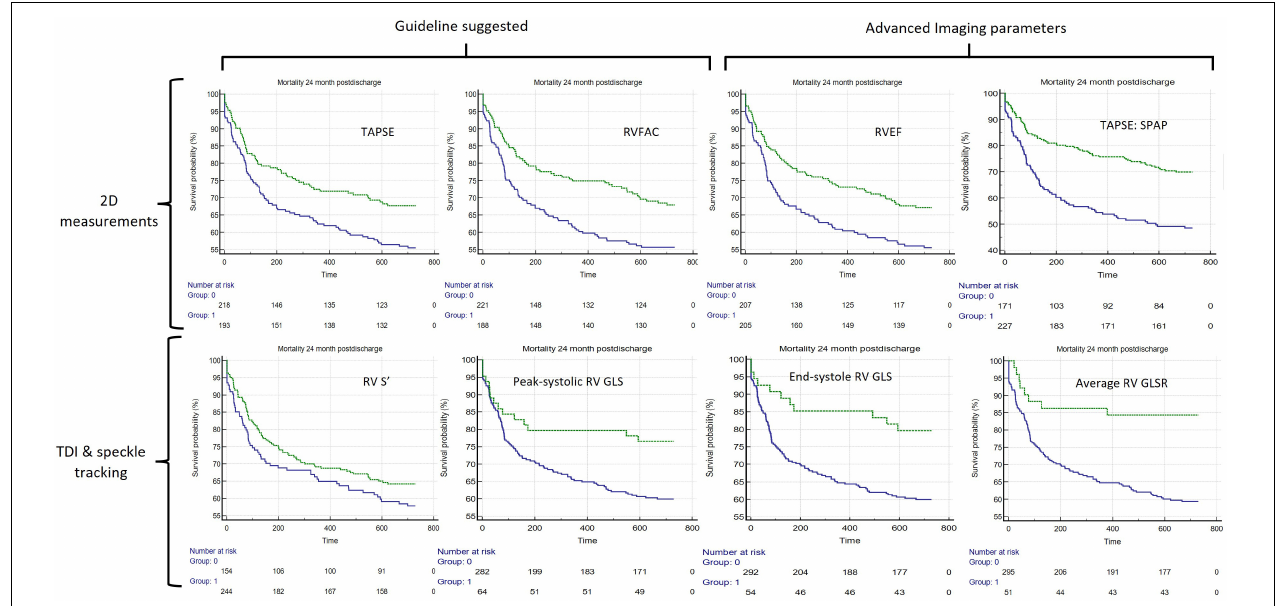
FIGURE 2 | Unadjusted Kaplan–Meier curves comparing 8 different assessments of RV systolic function, in all. The green lines represent the unimpaired systolic function and blue lines represent impaired systolic function. The echo parameter assessment of systolic function is displayed in the top-right corner of each (clockwise from top-left): TAPSE ≤ 1.6 cm, RV FAC ≥ 38.2%, 2D ellipsoid RVEF < 46.9%, TAPSE:SPAP < 0.0268 (cm/mmHg). RV S’ ≤ 0.09 m/s, Peak systolic RV GLS > − 18.6%, End-systole RV GLS > − 18% and RV mean GLSR > − 1.8 s − TAPSE, Tricuspid Annular Plane Systolic Excursion; RV FAC, RV Fractional Area Change; RV S’ RV Tissue Doppler Imaging peak systolic velocity; RVEF, two-dimensional RV ellipsoid ejection fraction; RV GLS, RV Free Wall Global Longitudinal Strain; mean RV GLSR, mean RV free wall global longitudinal strain rate; TAPSE:SPAP, TAPSE to Systolic Pulmonary Artery Pressure Ratio.